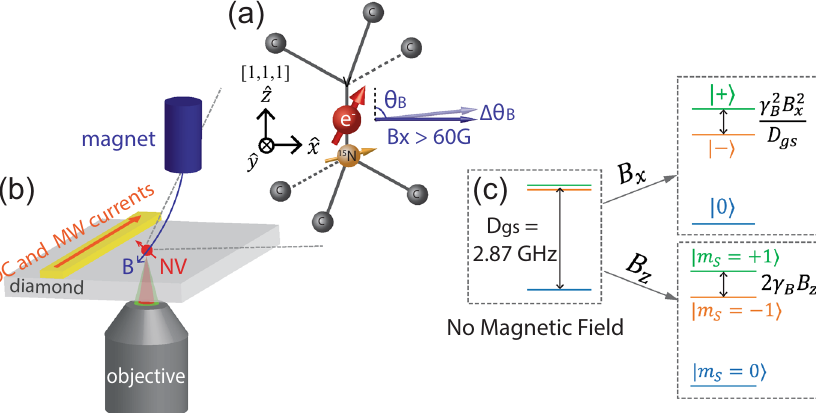
Fig. 1 Schematic of the NV center and experimental setup. a 15 NV in the presence of a bias magnetic fi eld acting perpendicular to the NV symmetry axis. The coordinate system is depicted on the left. The bias magnetic fi eld direction rotates in the XZ plane. θ B is varied around 90° and Δ θ B is the signal to be detected. b A permanent magnet and DC currents in the metal stripline together control the magnetic fi eld at the NV. c NV electron energy eigenstates under parallel ( B z ) and perpendicular ( B x ) magnetic fi elds.